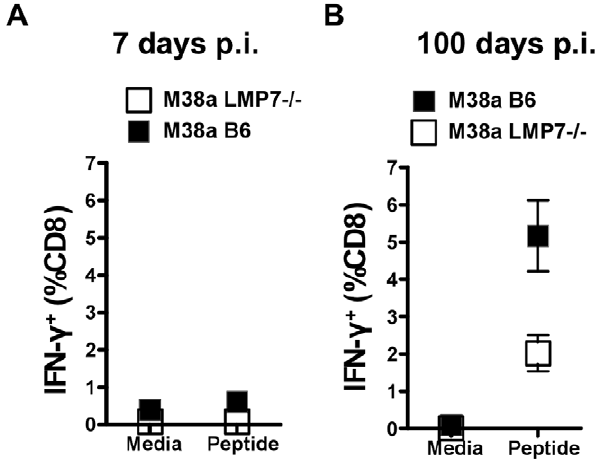
Figure 4. CD8 + T cell responses to inflating epitope M38 in LMP7 2 / 2 mice infected with MCMV. A. Splenocytes were prepared from spleens of LMP7 2 / 2 and C57BL/6 control mice 7 days p.i.(n=6), pooled, and incubated in the presence of BFA with either